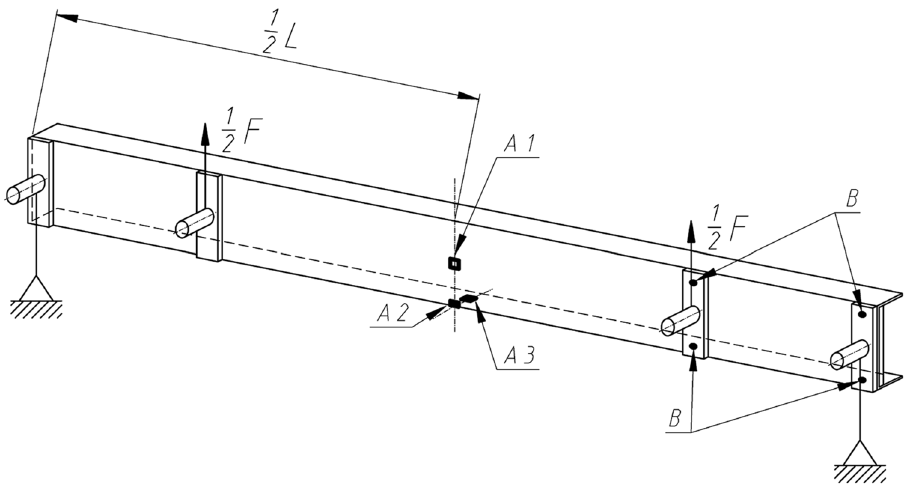
Figure 3. Schematic of the placement of strain gauges (A1, A2, A3) and displacement sensors